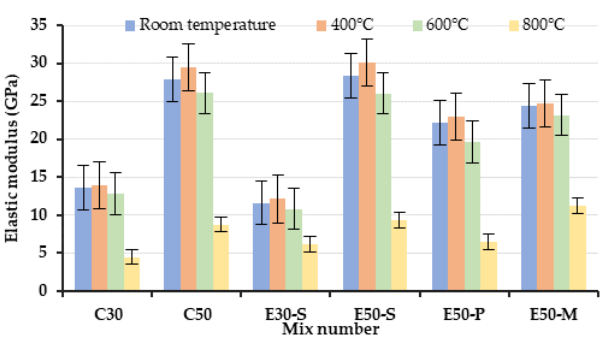
Figure 8. Results of elastic modulus.